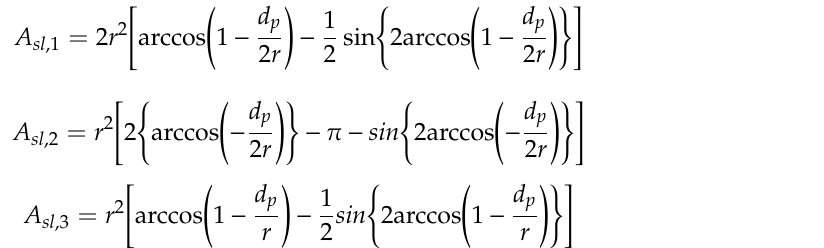
Figure 4. Three idealized pit configurations of corroded wires: ( a ) Type 1: hemispherical pit, ( b ) Type 2: concave pit, and ( c ) Type 3: planar pit.